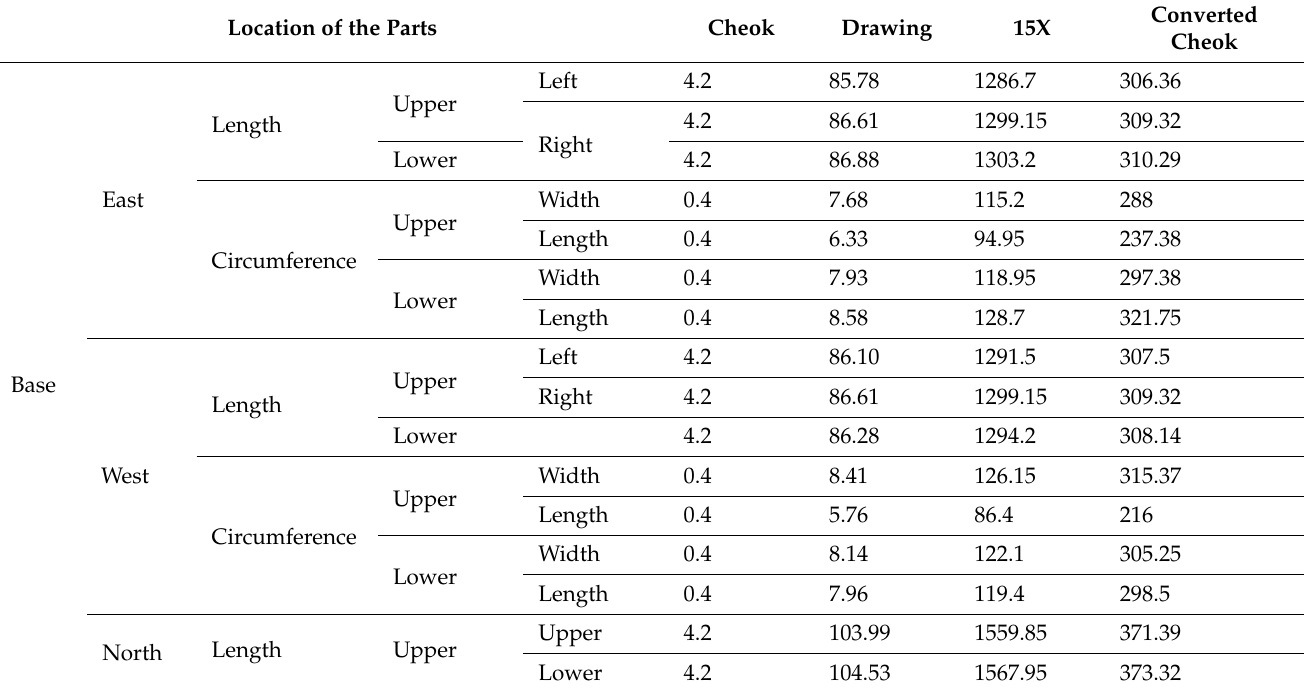
Table 1. Comparison of base